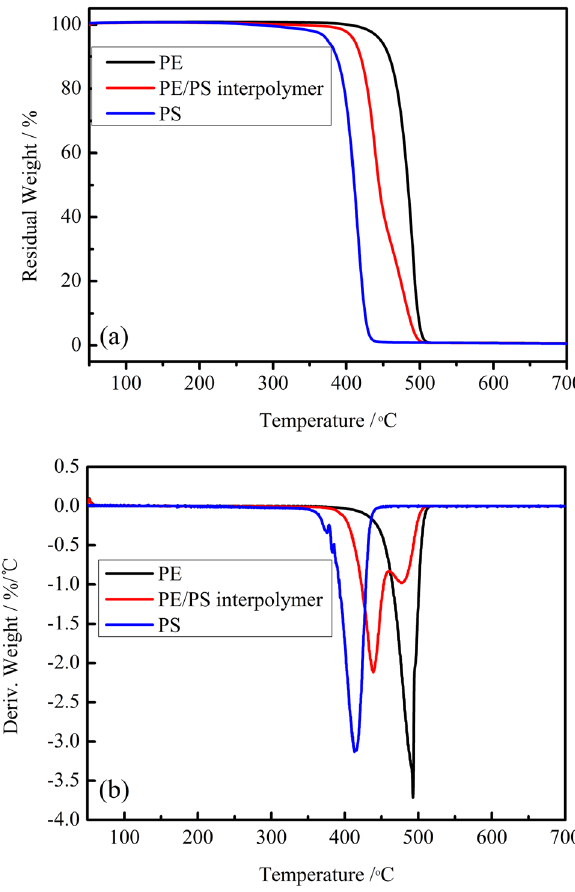
Figure 6: Thermal behavior of PS, LDPE, and LDPE/PS interpolymer resin particles in nitrogen atmosphere: ( a ) TGA curves and ( b ) DTG curves.